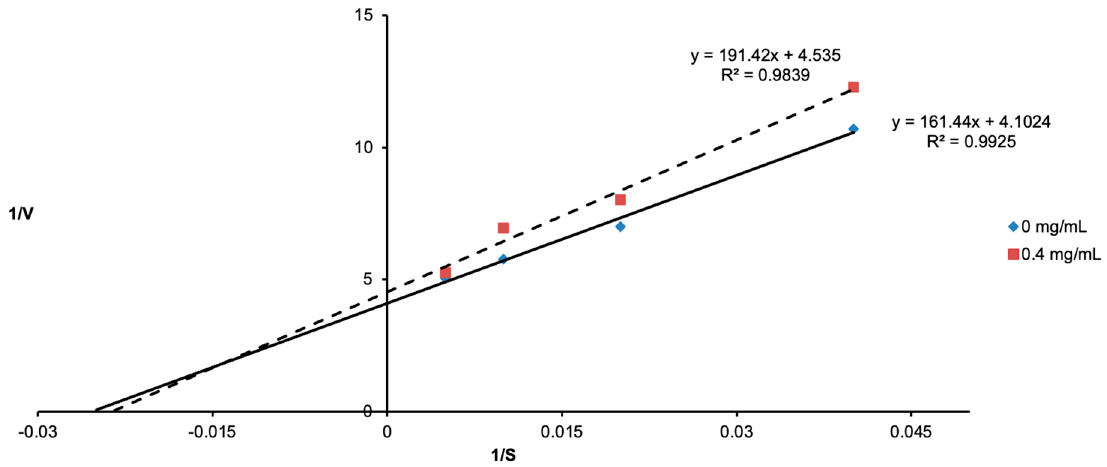
Figure 2. Lineweaver-Burk plot of conversion of L-DOPA to dopachrome by tyrosinase in the presence and absence of bush tea extract. Table 2. IC 50 values for inhibition of mushroom tyrosinase by Athrixia phylicoides metabolites and kojic acid.